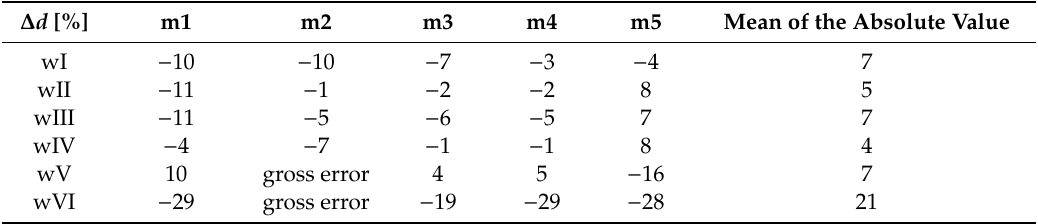
Table 9. Relative thickness determinations error caused by calculating the dielectric constant based on amplitudes.